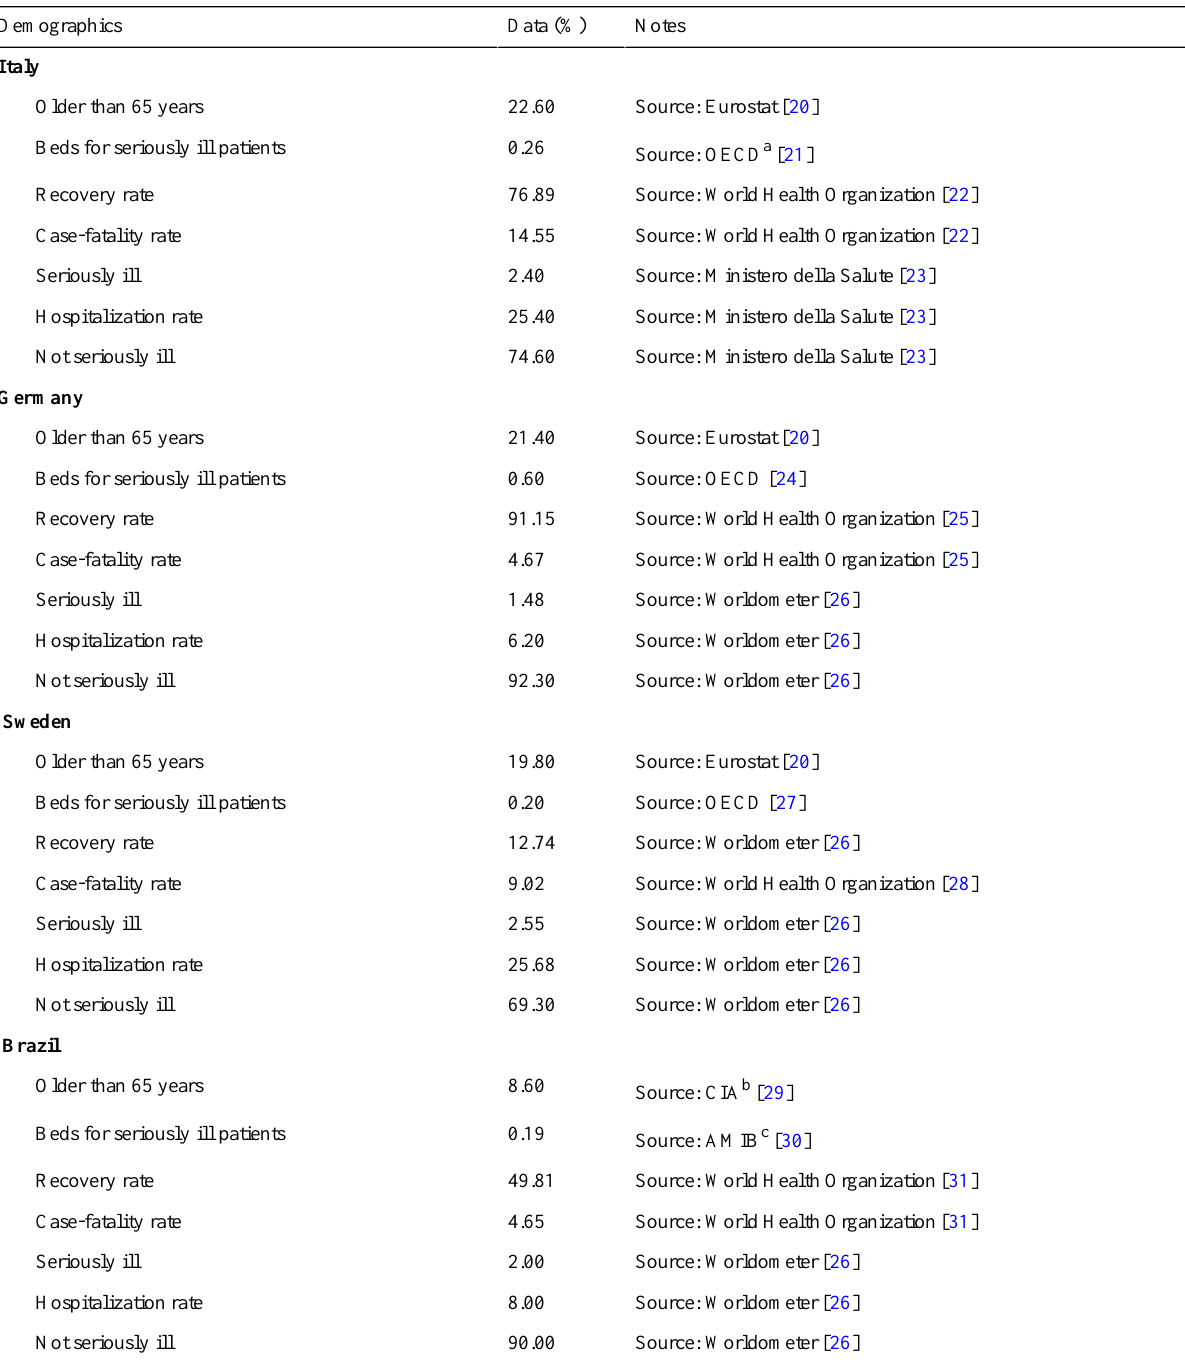
Table 1. Reference data used for constructing the